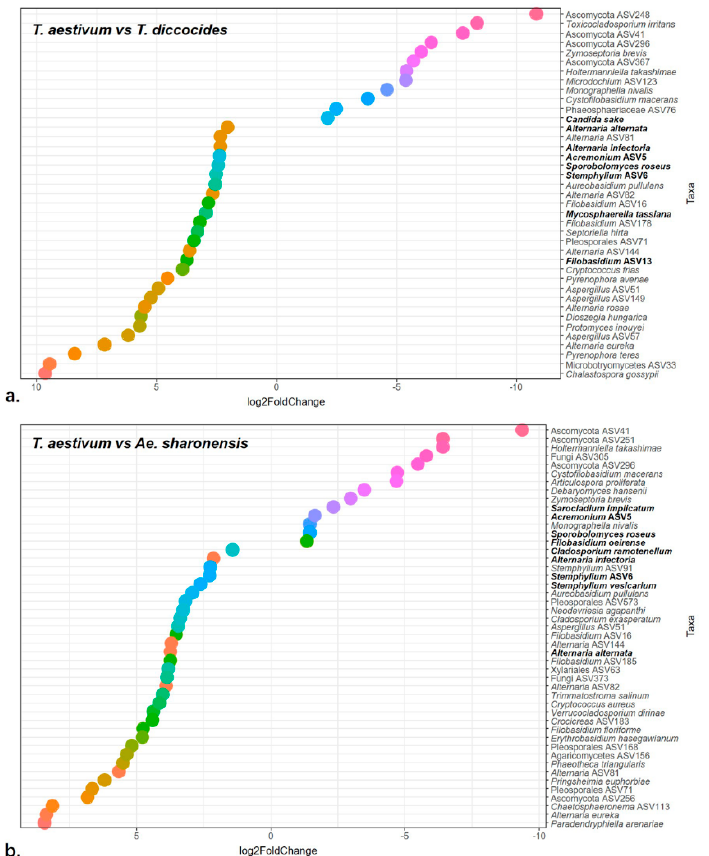
Figure 8. Differentially enriched fungal taxa . Differentially enriched taxa were identified using DeSEQ2 analysis. The graphs show a pair-wise comparison of fungal taxa that are differentially enriched at log2 fold or higher. Fungal taxa are shown on the Y-axis, and the dots represent significantly higher (Log 2 Fold > 0) and lower (Log 2 Fold < 0) abundances in wheat compared with either TD ( a ) or AS ( b ). Highly abundant taxa (see Figure 4) are in bold letters. Fungal genera are color coded.